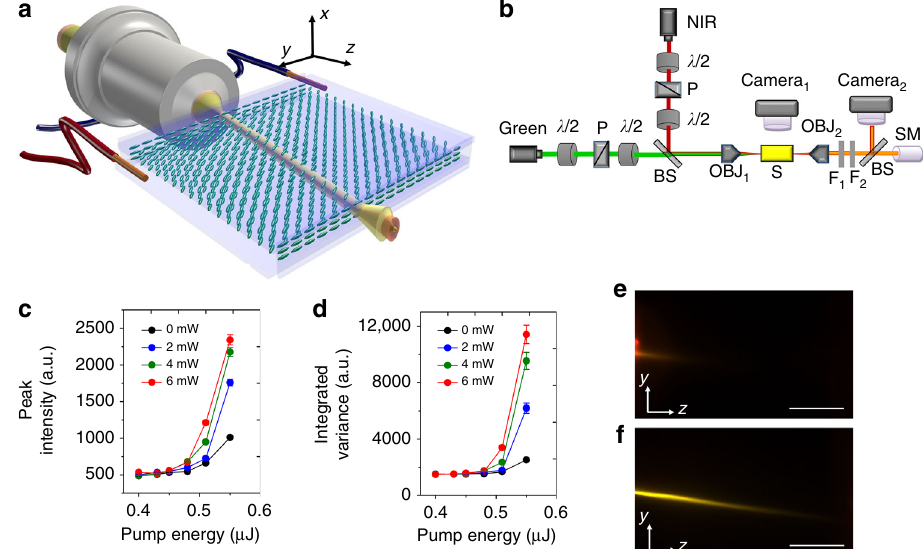
Fig. 1 Con fi guration and basic features of nematicon-assisted random laser. a Planar cell con fi guration and orientation. Here, the two wires allude to the application of a bias voltage across the cell thickness (see Methods). The molecular director distribution n (optic-axis) is represented by blue ellipses. b Sketch of the basic experimental setup, with green pulsed pump and continuous-wave near-infrared (NIR) lasers, microscope objectives (OBJ) to inject and collect light, beam splitters (BS), polarisers (P), waveplates ( λ /2), notch fi lters (F 1 and F 2 ), spectrometer (SM). c Typical input – output random laser characteristics for various soliton powers and an ordinary-wave pump, from the mean peak intensity. The legend indicates the input power of the near- infrared nematicon. d As in c but from the integrated variance σ 2 I of the averaged spectra (see Eq. (9) in the Methods) over 200 gated acquisitions (in 100 ms windows), carrying out the analysis detailed in the Methods. The error bars in c and d correspond to standard deviation over 200 acquisitions. e Photograph of emitted random laser light in the yz plane for a pump energy E = 0.55 μ J, without nematicon. f As in e but in the presence of a 6 mW nematicon (the near-infrared was fi ltered out). The scale bars indicate a length of 500 μ